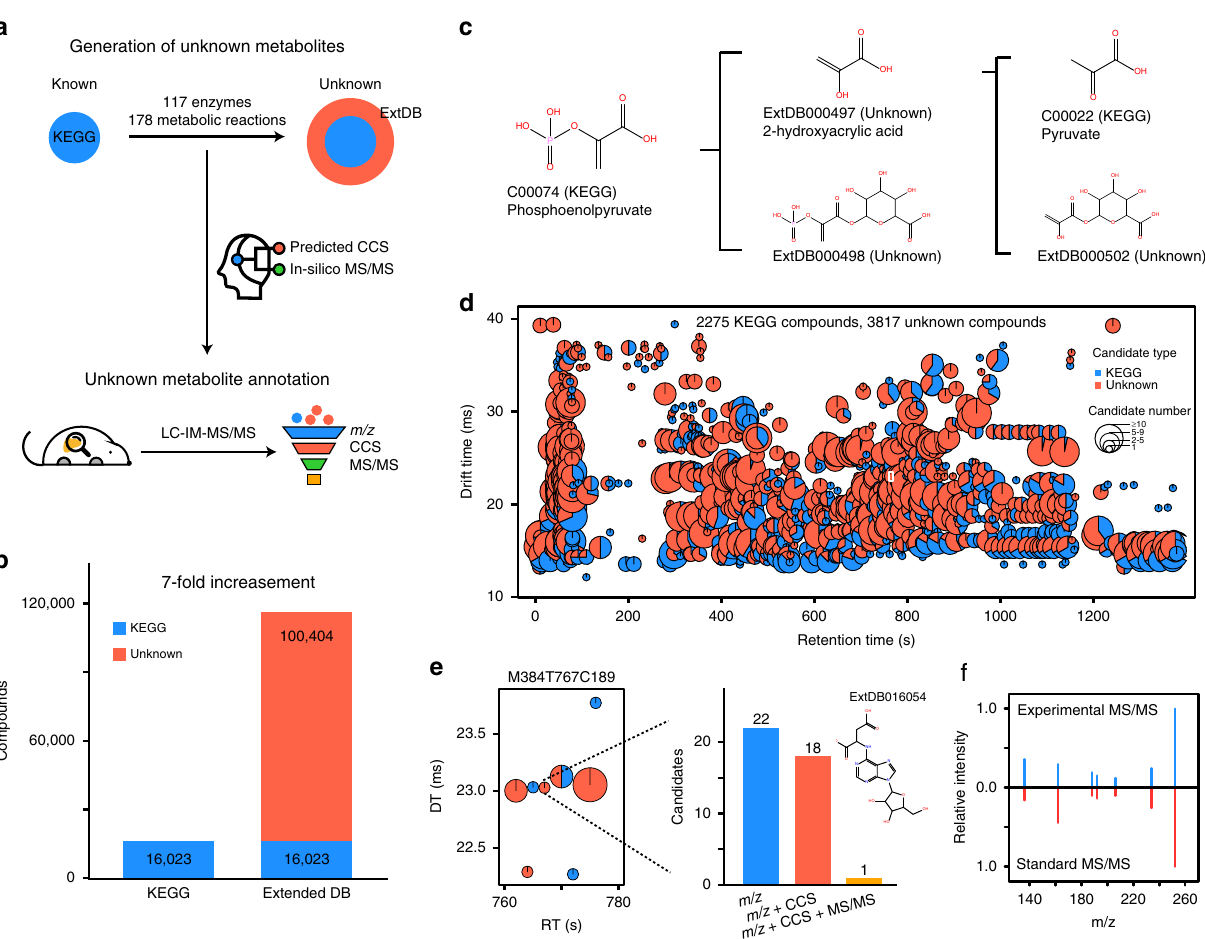
Fig. 5 AllCCS enables unknown metabolite annotation. a Schematic illustration of generation of possible unknown metabolites from KEGG and prediction of CCS and MS/MS spectra to support multi-dimensional match-based annotation; b number of unknown metabolites; c generation of unknown metabolites from phosphoenolpyruvate; d annotation of known and unknown metabolites in mouse liver with the multi-dimensional match; the inner pie plot is the composition of known and unknown metabolites; e an unknown metabolite annotation for the feature M384T767C189; f validation of unknown metabolite using chemical standard. Source data are provided as a Source Data fi